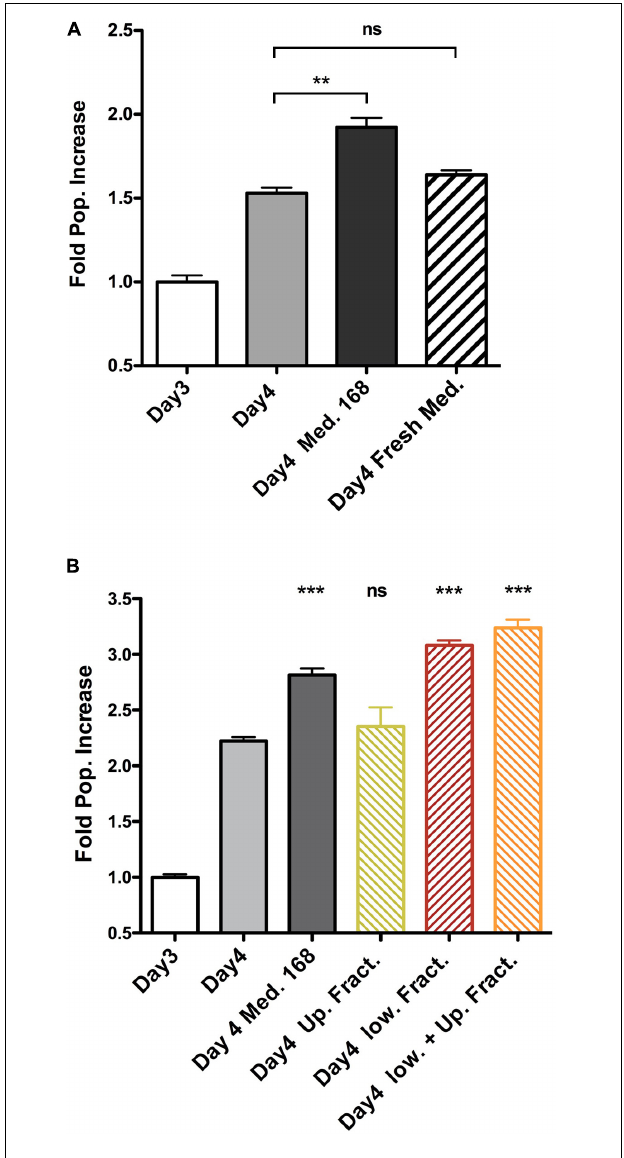
FIGURE 4 | Soluble factor secreted by 168FARN cells accelerates proliferation of the 4T07 cells. (A) 4T07 cells were grown for 3 days at which point their medium was either left unchanged, or replaced by either 168FARN-conditioned medium or fresh medium, as indicated. Cells were collected 24 h later and counted. Cell numbers at day 3 were arbitrarily set at 1 in order to include the data from three independent experiments. (B) The experiment was performed as in panel (A) . but the medium conditioned by 168FARN cells was fractionated by membrane ultrafiltration with a 3 KDa molecular cutoff. After complementing the low and the high MW fractions, respectively, with 10% serum and DMEM, the media were used to grow the 4T07 cells, as in panel (A) . The two fractions were also combined as a control. ns, not significant; ** p < 0.01, *** p < 0.001, all compared to Day 4